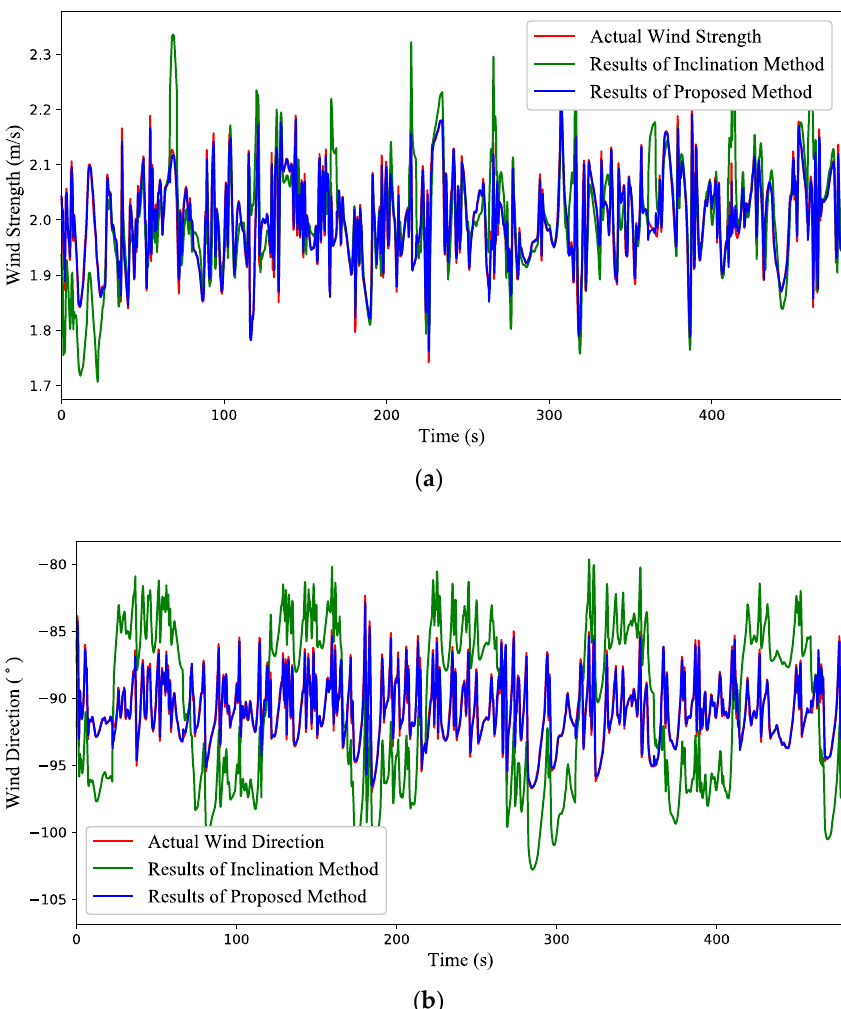
Figure 12. Simulation results of the time-varying wind estimation with a quadrotor in flight condition. ( a ) The wind strength. ( b ) The wind direction.